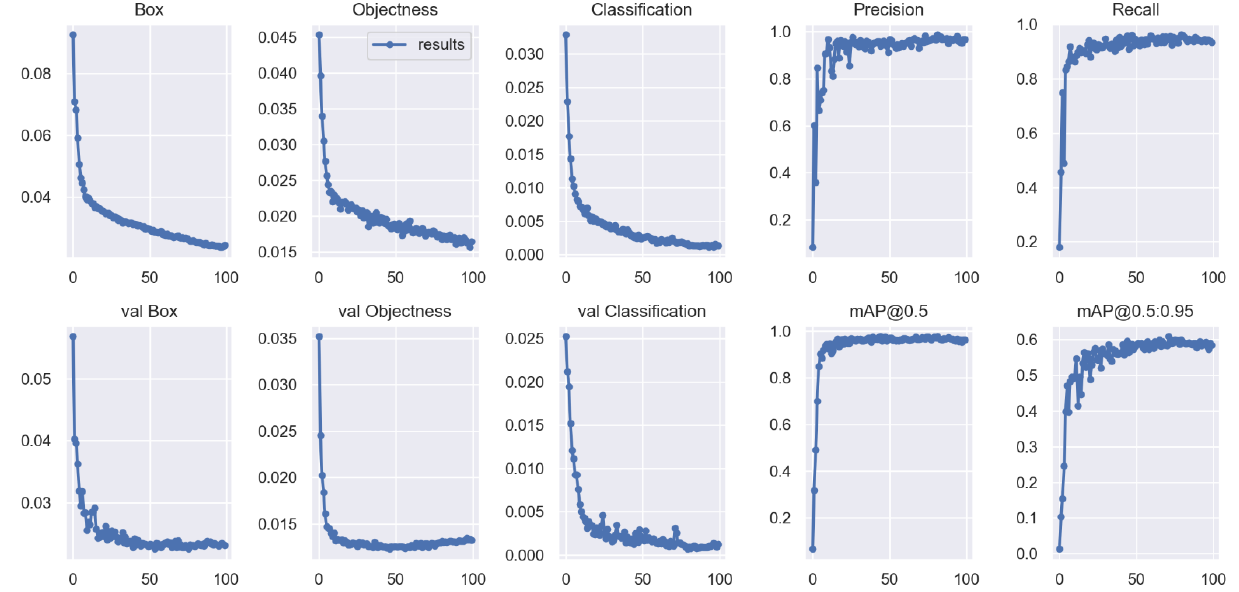
Figure 13. Plots of Box loss, Objectness loss, Classification loss, Precision, Recall and mean Average